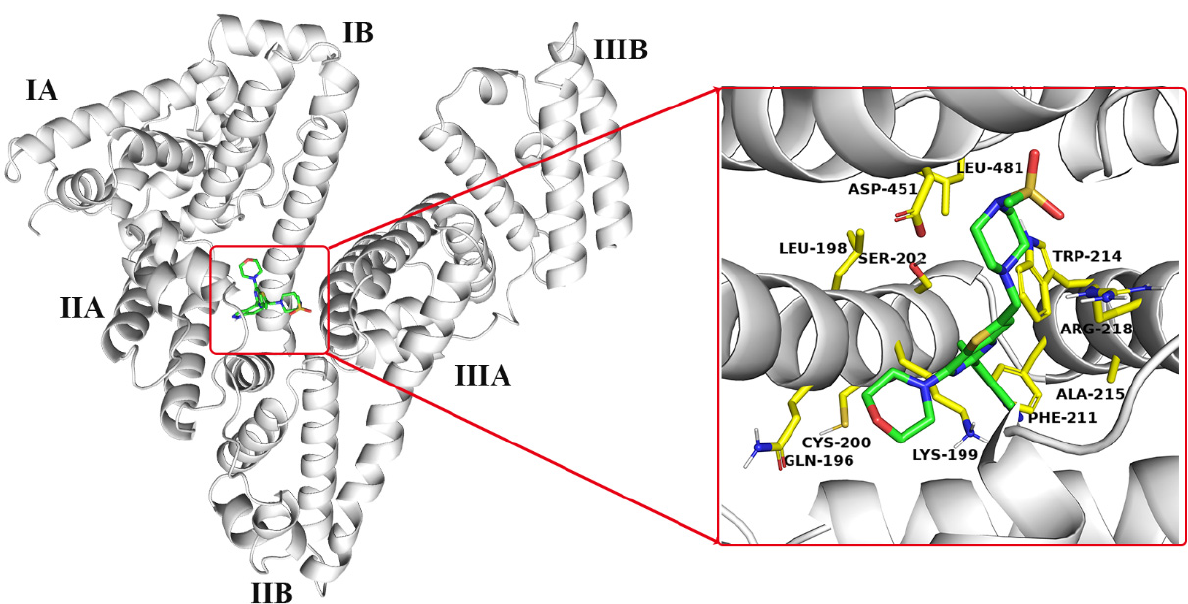
Figure 2. Molecular docking results of GDC-0941 binding to HSA. Left image shows the binding of GDC-0941 on HSA. Right image shows the view of the site of GDC-0941 binding to HSA. HSA is represented as a white cartoon; amino acid residues are represented as yellow sticks; GDC-0941 is represented as a green stick with nitrogen atoms in blue, oxygen atoms in red, and sulfur atoms in